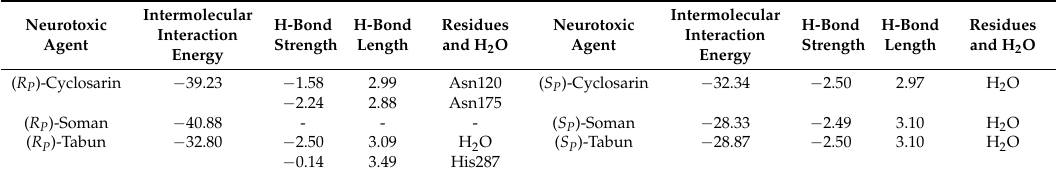
Table 2. Values of the parameters obtained by molecular docking calculations for the OP in the DFPase active site, by employing the conformations selected in the PCA analysis (energies in kcal · mol − 1 ; lengths in angstroms; units correspond to those used by default in the MVD ® software). Neurotoxic Intermolecular H-Bond H-Bond Residues Agent Interaction Energy Strength Length and H 2 O